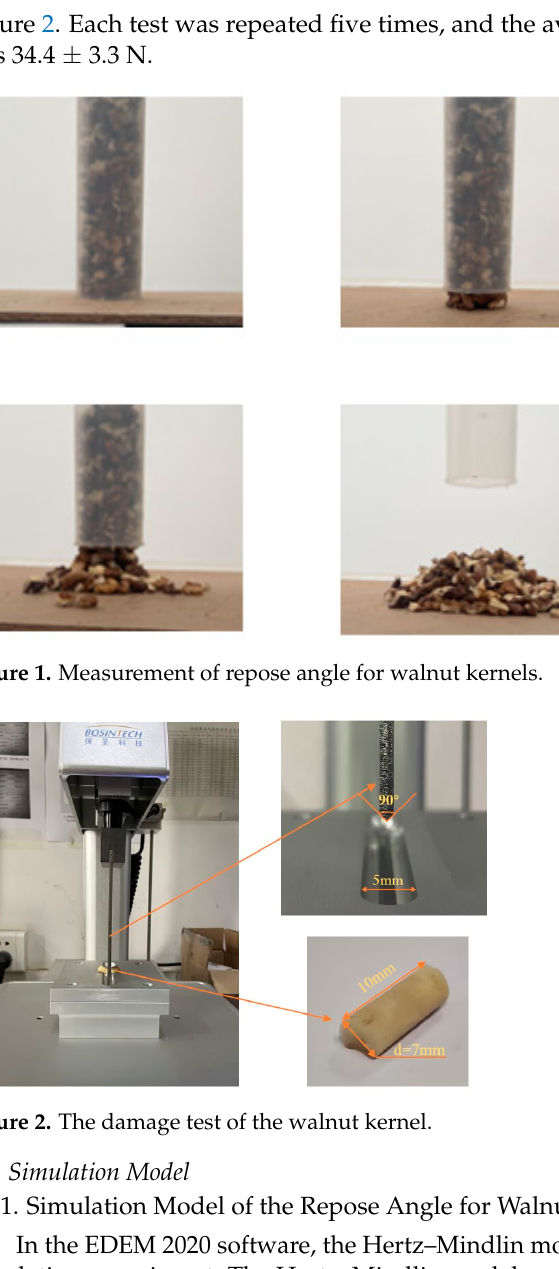
Figure 2. Each test was repeated five times, and the average maximum destructive force was 34.4 ± 3.3 N.